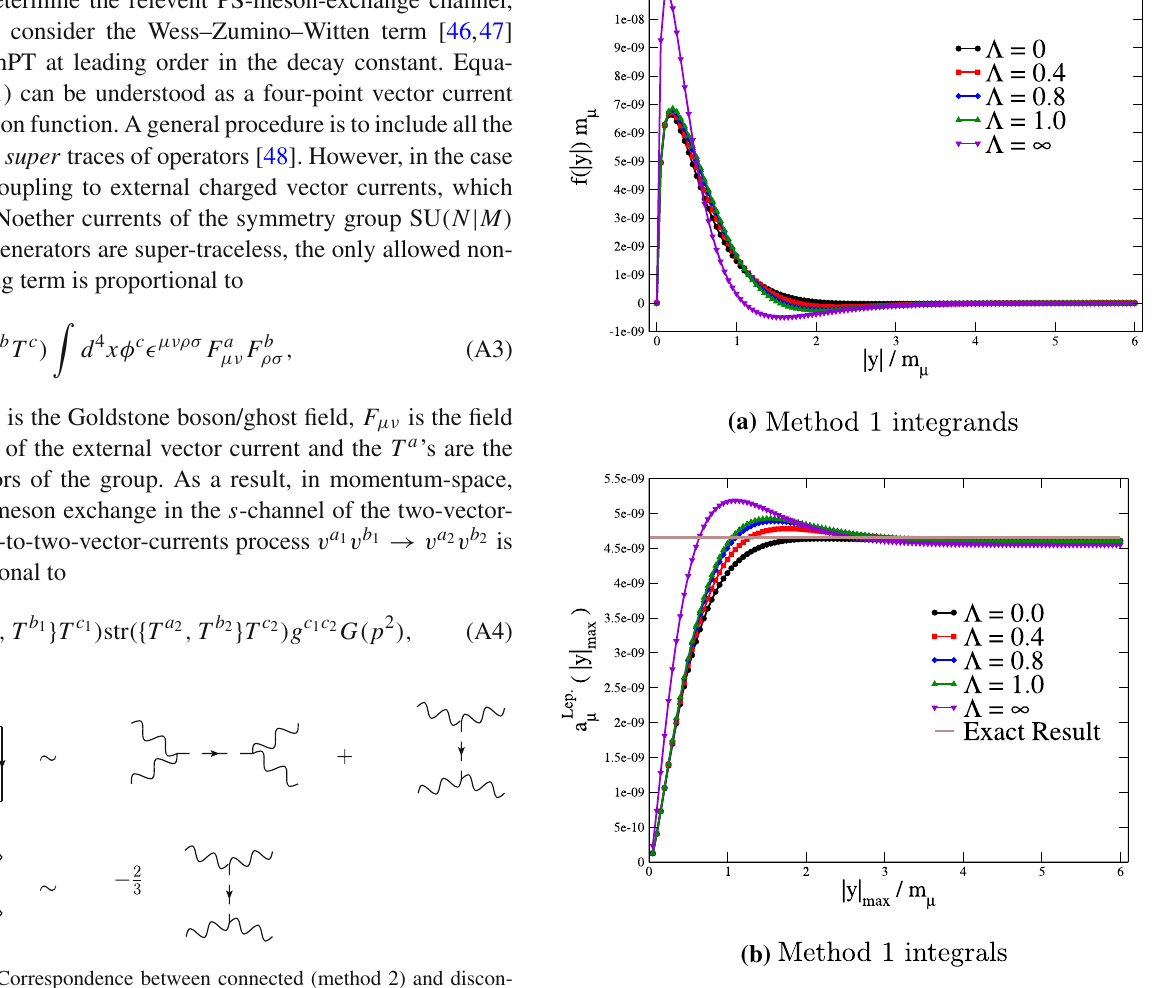
Fig. 18 Top: the integrands in method 1 of several (cid:12) choices of the new subtracted kernel. Bottom: the results of the partial integration of the integrands up to some | y | max . These results were obtained with lepton mass equal to the muon mass and the exact result used was 4 . 6497 × 10 − 9